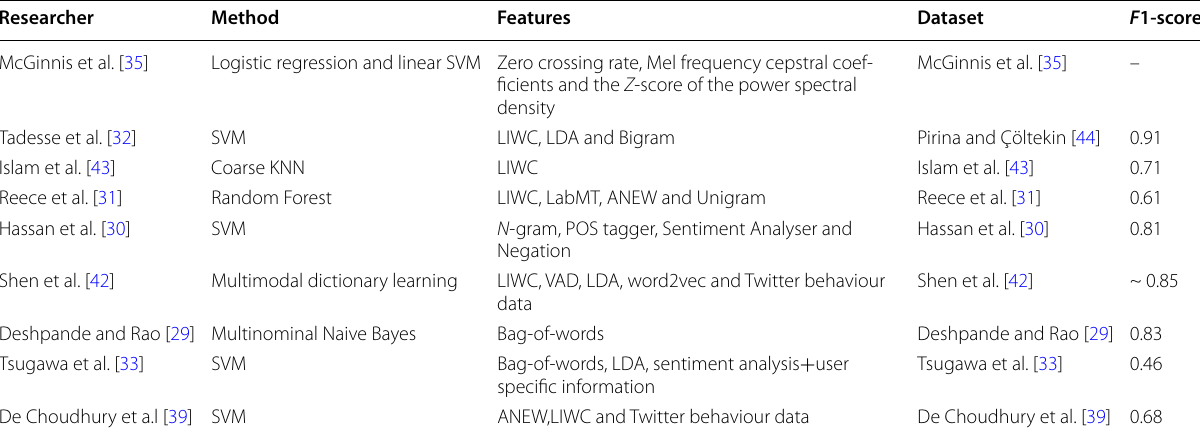
Table 1 Detection systems and their features